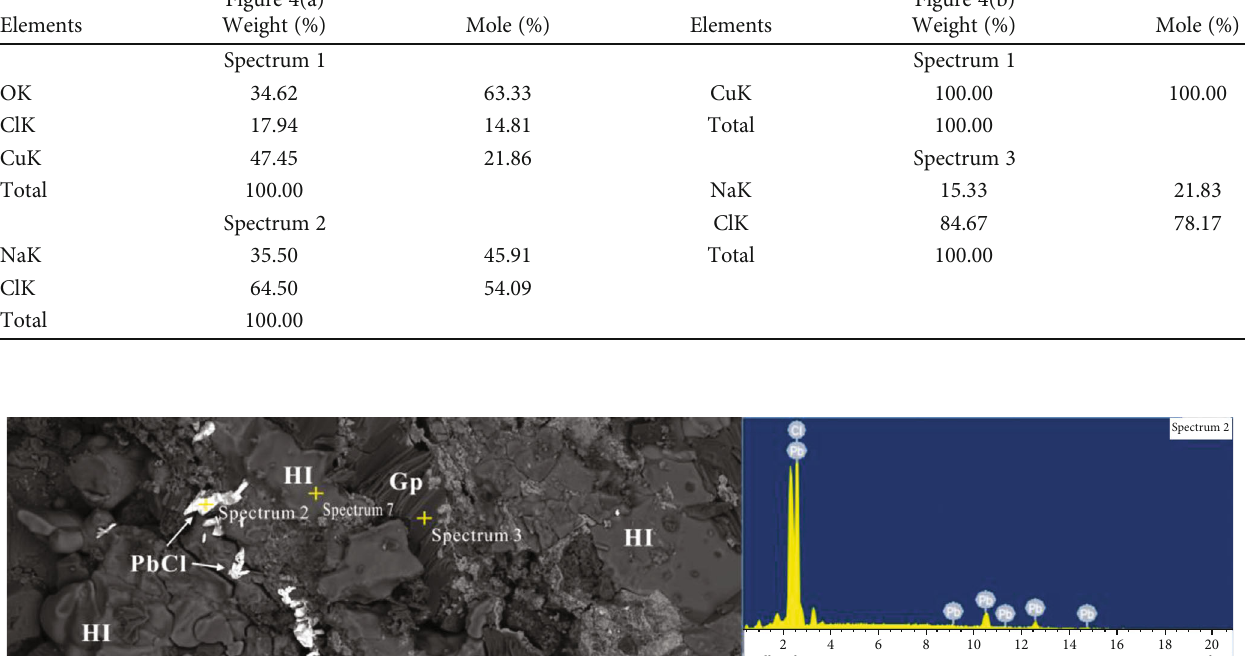
Table 3: The concentration of elements on grains in SEM of Figure 4. Figure 4(a)